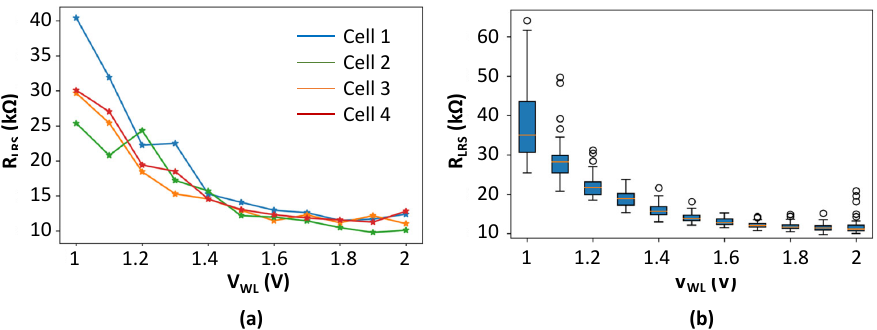
Figure 11. ( a ) R LRS versus V WL for 4 different cells and ( b ) R LRS box plots versus V WL voltage steps. Each box plot gathers 49 measurements.